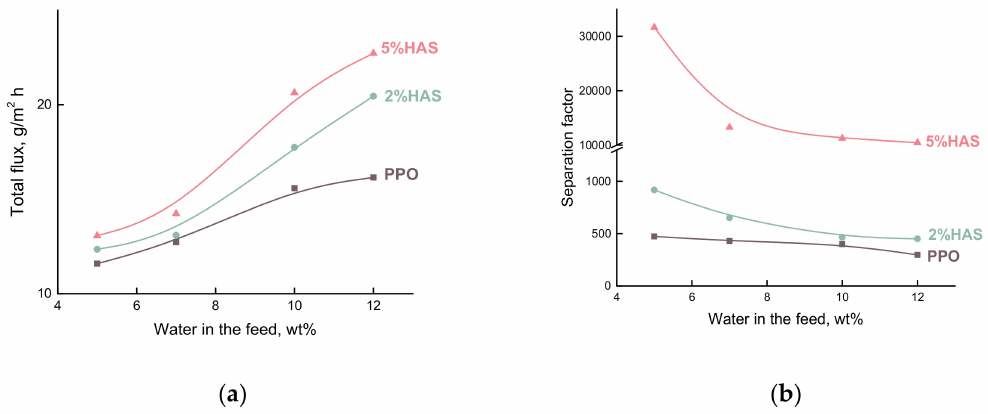
Figure 5. Dependences of ( a ) the total flux and ( b ) the separation factor ( β water / EG ) on water concentration in the feed for the pervaporation of ethylene glycol (EG) / water mixture using the PPO-based membranes, 50 ◦